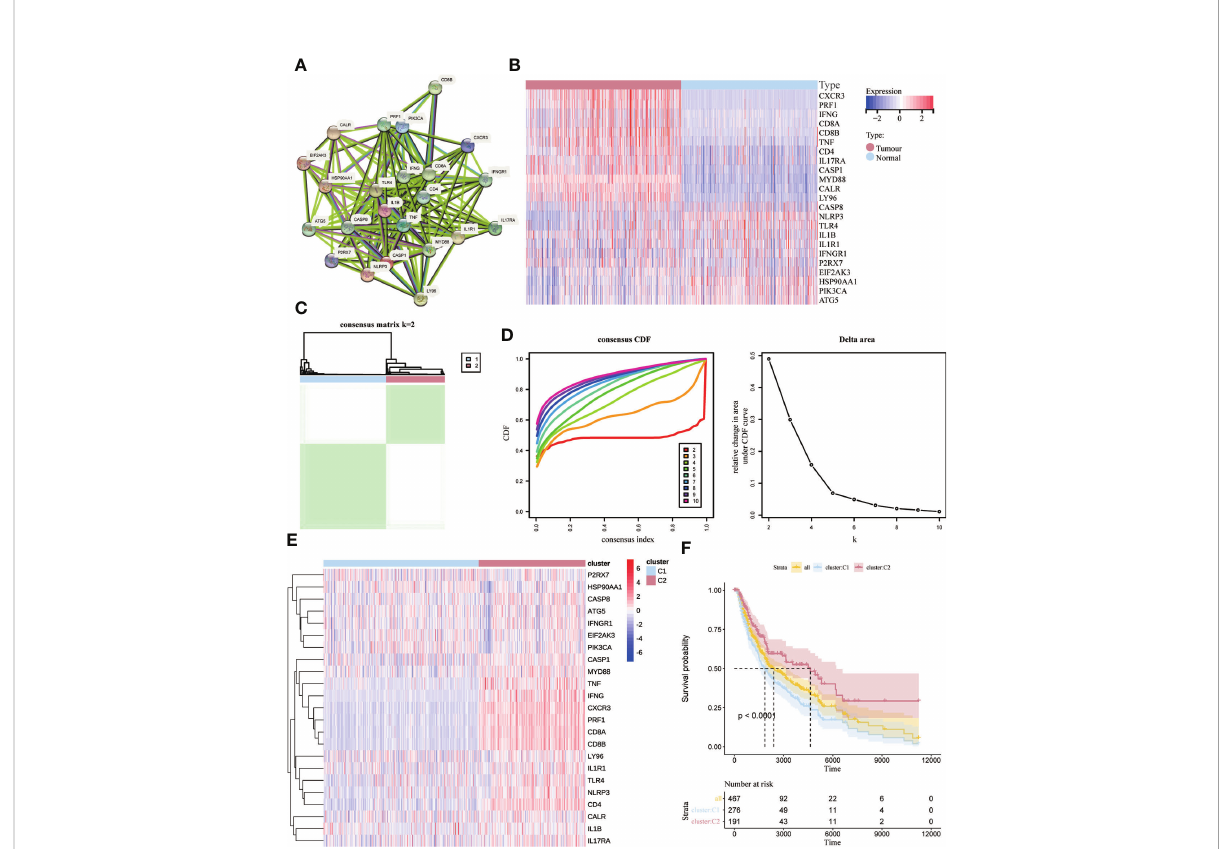
FIGURE 2 Identi fi cation of ICD-associated subtypes by consensus clustering. (A) Protein interactions between ICD-associated genes; (B) heat map showing the expression pro fi les of 23 ICD genes in normal and SKCM samples from the TCGA database; (C) heat map depicting the consensus clustering solution (k = 2) for 23 genes in 467 SKCM samples; (D) d -area curves of the shared clusters representing the cumulative distribution function from k = 2 to 10 (CDF) curves under the relative change in the area; (E) Heat map of the expression of 23 ICD-related genes in different subtypes. Red represents high expression, and blue represents low expression; (F) Kaplan-Meier curves for ICD high subtype and ICD low subtype OS. p <